Question: Briefly state, in one sentence, what is plotted here.
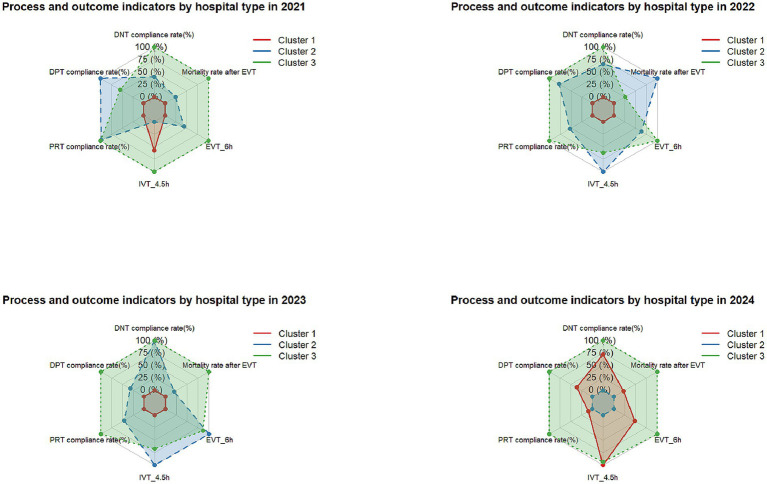
Answer: Cluster classification of hospitals based on reperfusion process and outcome indicators from 2021 to 2024. Radar plots display the performance of 33 hospitals clustered into three groups annually using K-means analysis of six indicators: compliance rates for DNT, DPT, and PRT; rates of intravenous thrombolysis within 4.5 h and endovascular therapy within 6 h; and in-hospital mortality after endovascular therapy. Cluster 3 (green): hospitals with higher observed process adherence, greater accessibility, and lower EVT-related in-hospital mortality, mostly tertiary centers. Cluster 2 (blue): hospitals with intermediate observed performance across indicators. Cluster 1 (red): hospitals with lower observed performance across several indicators, mainly non-tertiary centers. This clustering should be interpreted as an exploratory hospital-level classification. DNT, door-to-needle time; DPT, door-to-puncture time; PRT, puncture-to-recanalization time.